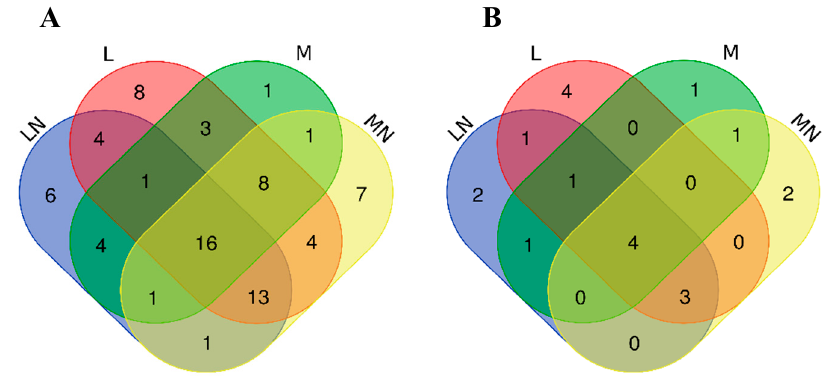
Figure 2. E. coli challenge-responsive proteins under L (red), LN (blue), M (green) and MN (yellow) exposure represented by Venn diagrams: ( A ) number of di ff erentially expressed, more abundant proteins and ( B ) number of di ff erentially expressed, less abundant proteins among the four treatments, as determined by liquid chromatography–mass spectrometry (LC-MS / MS). Complete list of proteins is presented in Supplementary Table S1B, and the lists of each intersection are indicated in Supplementary Table